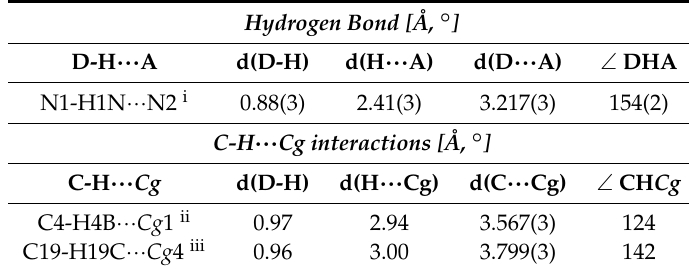
Table 3. Hydrogen bonding and C-H ··· Cg interactions